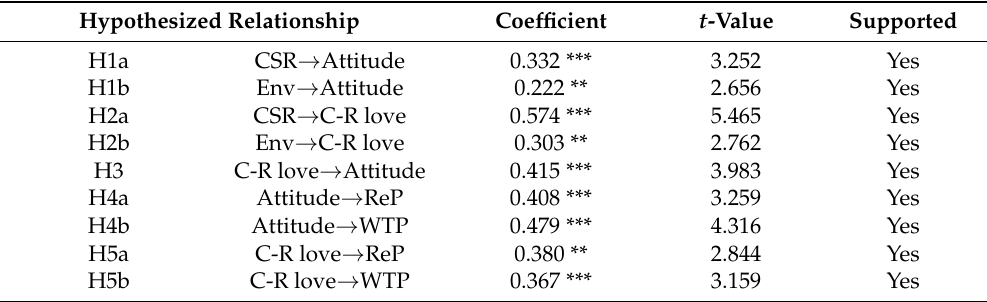
Table 3. Results of